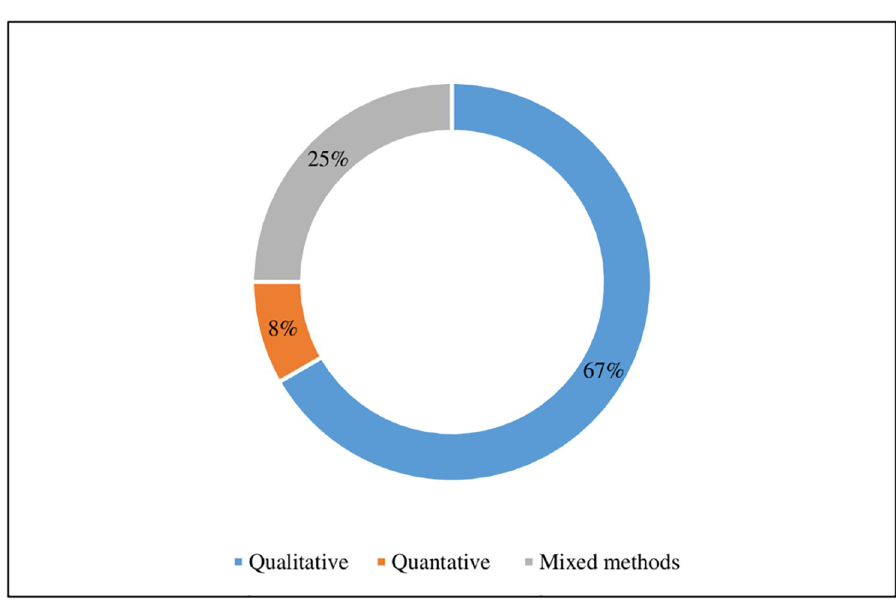
Fig 4. Study designs of the included